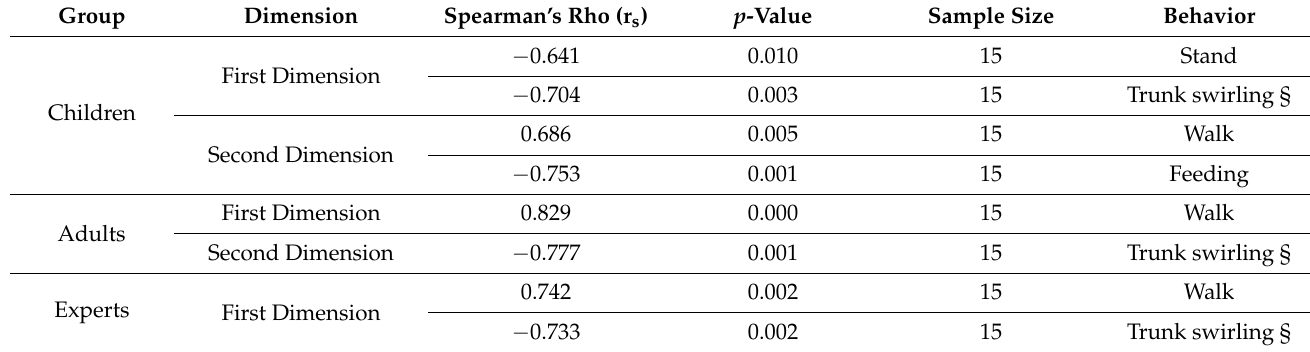
Table 5. Spearman’s rho correlations between generalized Procrustes analysis (GPA) scores on dimensions 1 and 2 of the three observer groups separately, and the relative duration/frequency § of the behavioral patterns shown by the 18 elephants in the 15